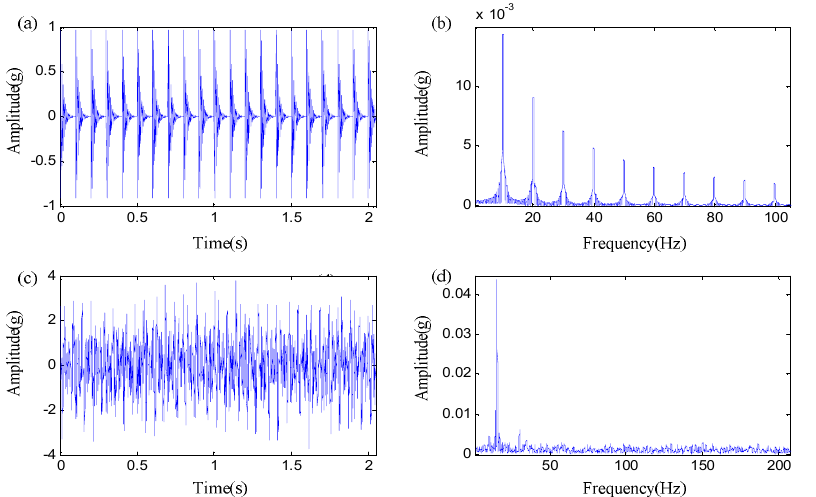
Figure 2. Simulation signal. ( a ) Impulse component. ( b ) Envelope spectrum of impulse component. ( c ) Synthetic signal. ( d ) Envelope spectrum of the synthetic signal.